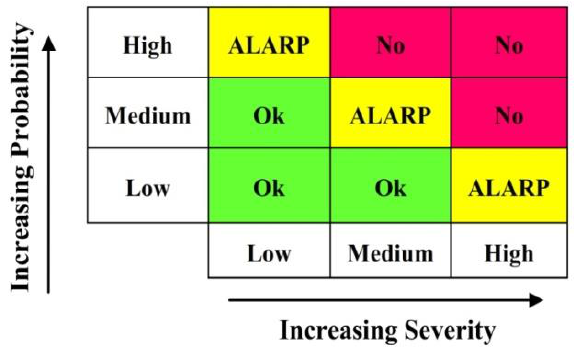
Figure 4. An illustration of the “Risk - Matrix” form of RACs.